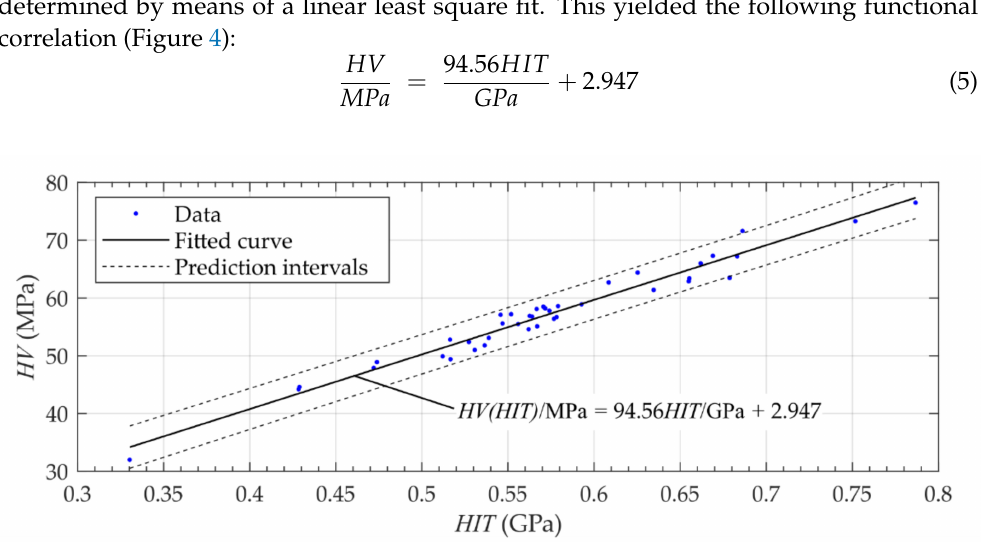
Figure 4. Functional relationship between indentation hardness HIT and the Vickers hardness HV with confidence bounds (confidence level of 0.95, resulting adjusted R-square of